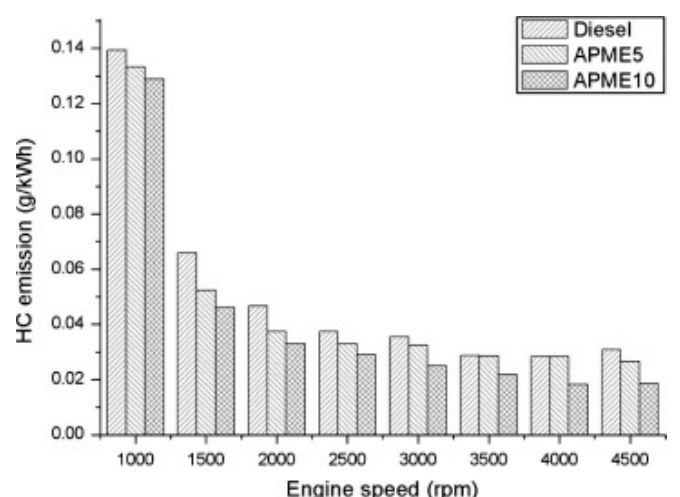
Figure 9. Hydrocarbon (HC) emissions of diesel and biodiesel fuels at different speeds at full load [87].